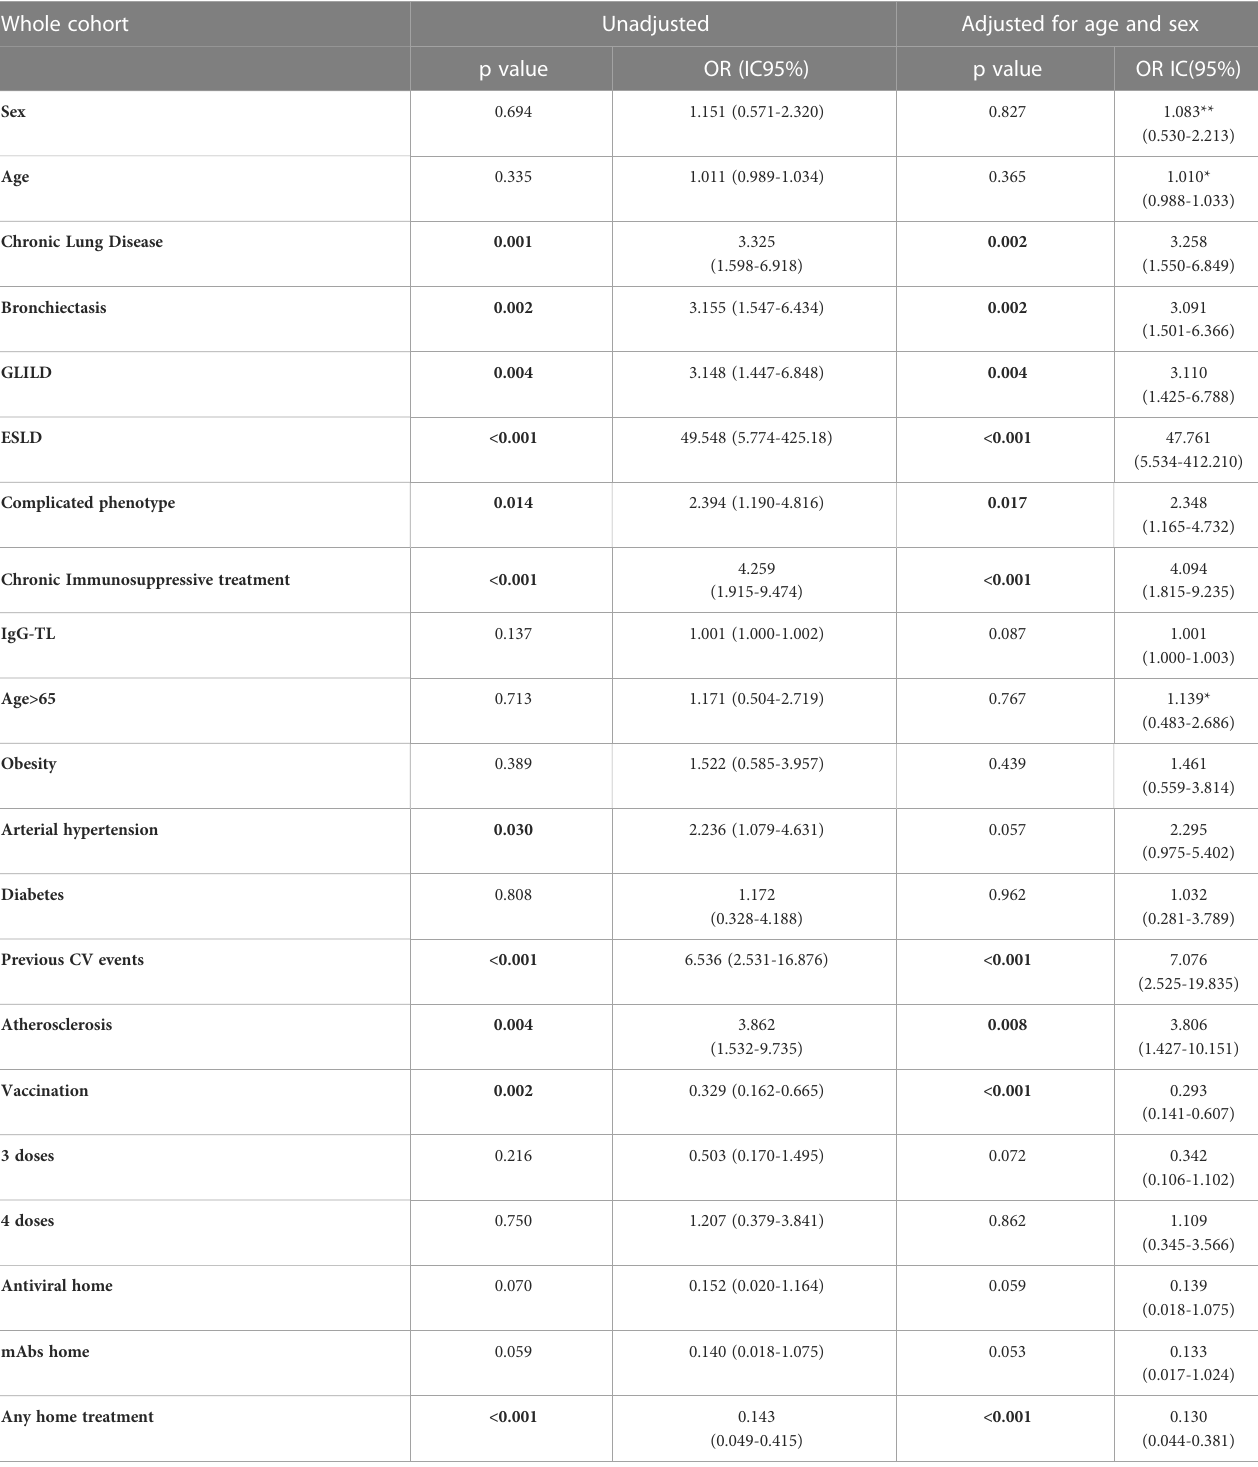
TABLE 4 Univariate analysis: hospitalization as outcome in the whole CVID cohort during the entire period of